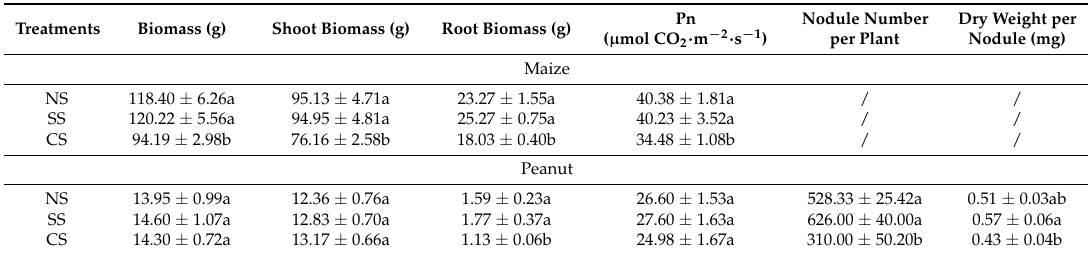
Table 2. Plant biomass, root nodulation, and net photosynthetic rate of both crops in three different intercropping